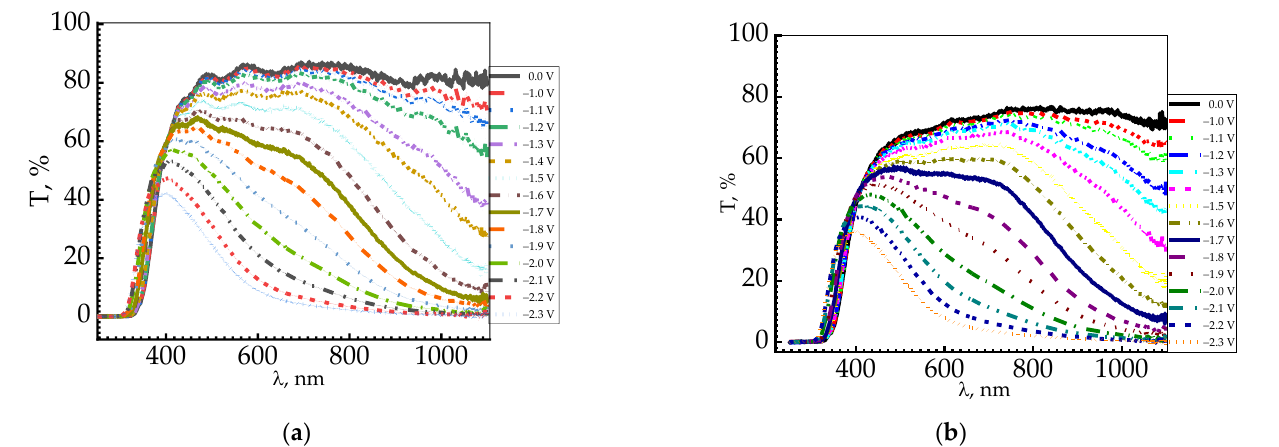
Figure 17. Optical transmission spectra of WO 3 film during electrochromic response obtain by electrochemistry (cathodic) deposition: ( a ) WO 3 at constant potential; ( b ) WO 3 /GO deposition at AC potential [77].